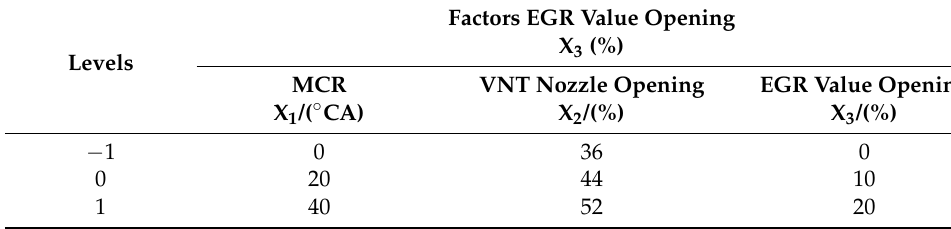
Table 2. Factors and levels of the test.